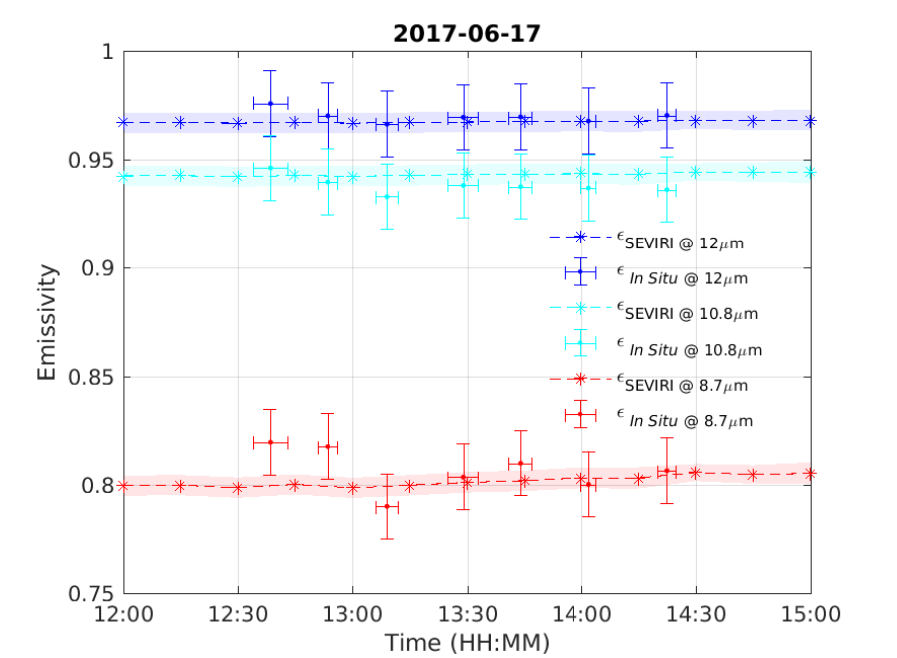
Figure 8. Comparison between SEVIRI and in situ emissivity for 17 June 2017. The shaded area gives the ± 1 σ confidence interval of the retrieval. The horizontal bar for the in situ observations correspond to the time taken to acquire a single